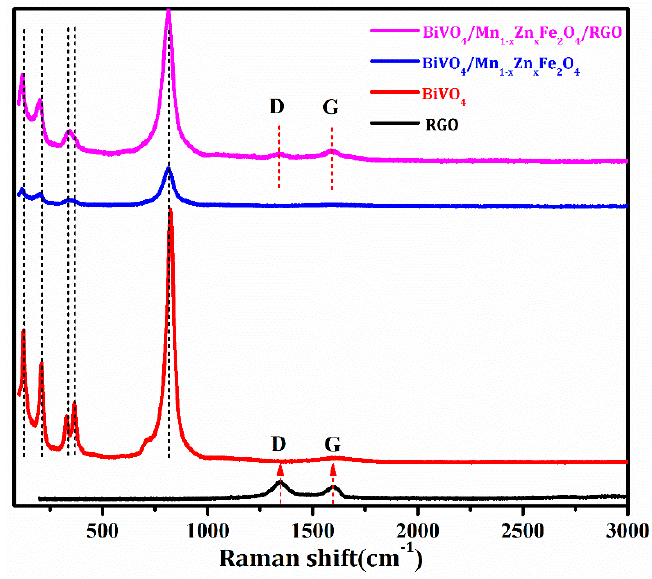
Figure 2. Raman spectra of RGO, BiVO 4 , Mn 1-x Zn x Fe 2 O 4 /BiVO 4 , and Mn 1-x Zn x Fe 2 O 4 /BiVO 4 /RGO.